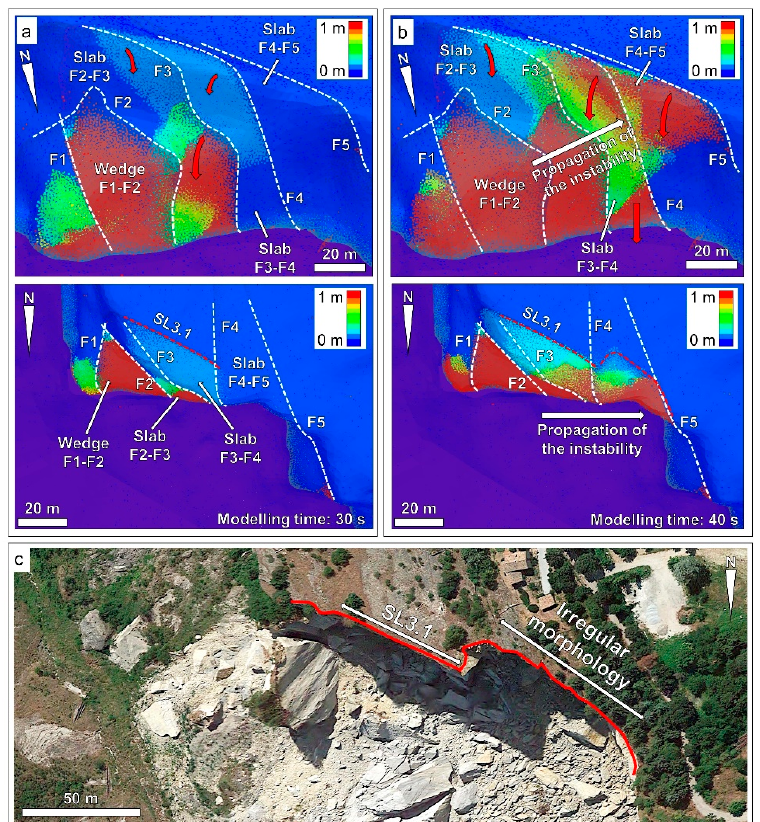
Figure 15. Overview of the slope model numerical analysis of the 2014 San Leo landslide after 30 s and 40 s (numerical time). ( a ) Oblique view (above) and plan view (below) of the total displacement contour plot after 30 s (modelling time); ( b ) Oblique view (above) and plan view (below) of the total displacement contour plot after 40 s (modelling time). Red arrows show the displacement of the fault-bounded slabs. White, dashed lines outline the first-order faults F1–F5. Note the westward propagation of the instability and the discontinuity SL3.1 marking the rear boundary of the landslide in the eastern part of the simulated slope; ( c ) 2017 satellite image from Google Earth, showing the morphology of the headscarp (red, solid line). Note the irregular, curved outline in the western part, and the linear morphology in the eastern part.